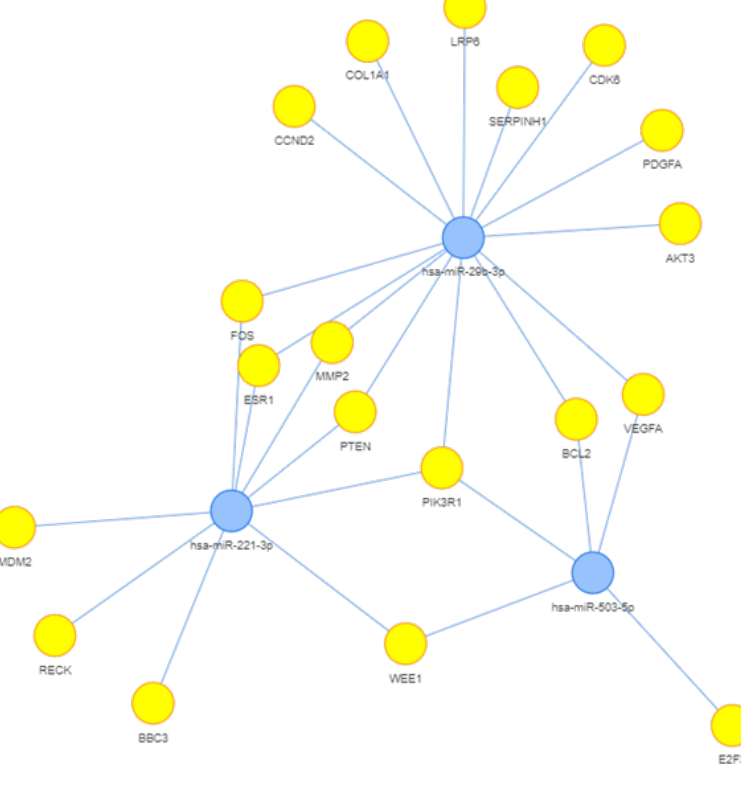
Figure 3. Network of miRNA targets.